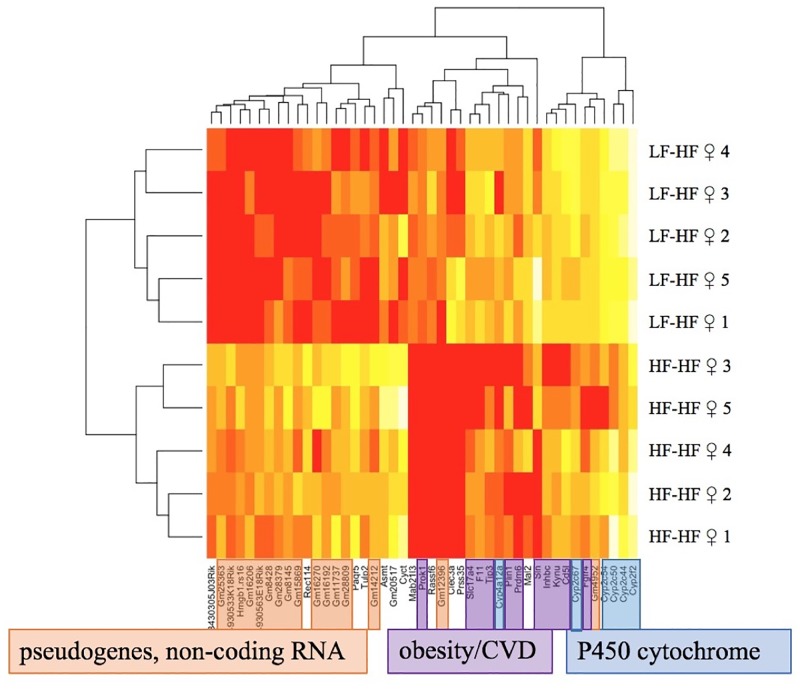
Clustering diagram of the heart gene expression libraries in the high-fat diet daughters.The 21 upregulated genes due to a maternal high-fat diet are mostly pseudogenes and non-coding RNAs. The 24 downregulated genes due to a maternal high-fat diet are primarily p450 cytochromes and genes already known to be involved in obesity and cardiovascular diseases. HF = High-fat diet, LF = Low-fat diet, the first diet listed is maternal diet and the second diet is the offspring diet, N = 10 per group.